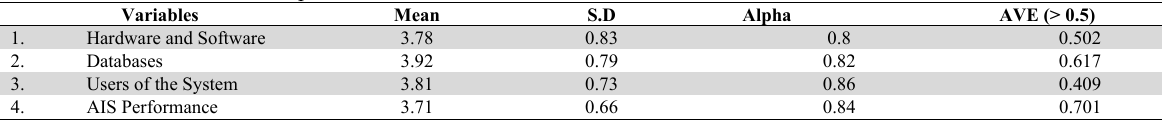
Means, S.D and Cronbach’s Alpha and AVE